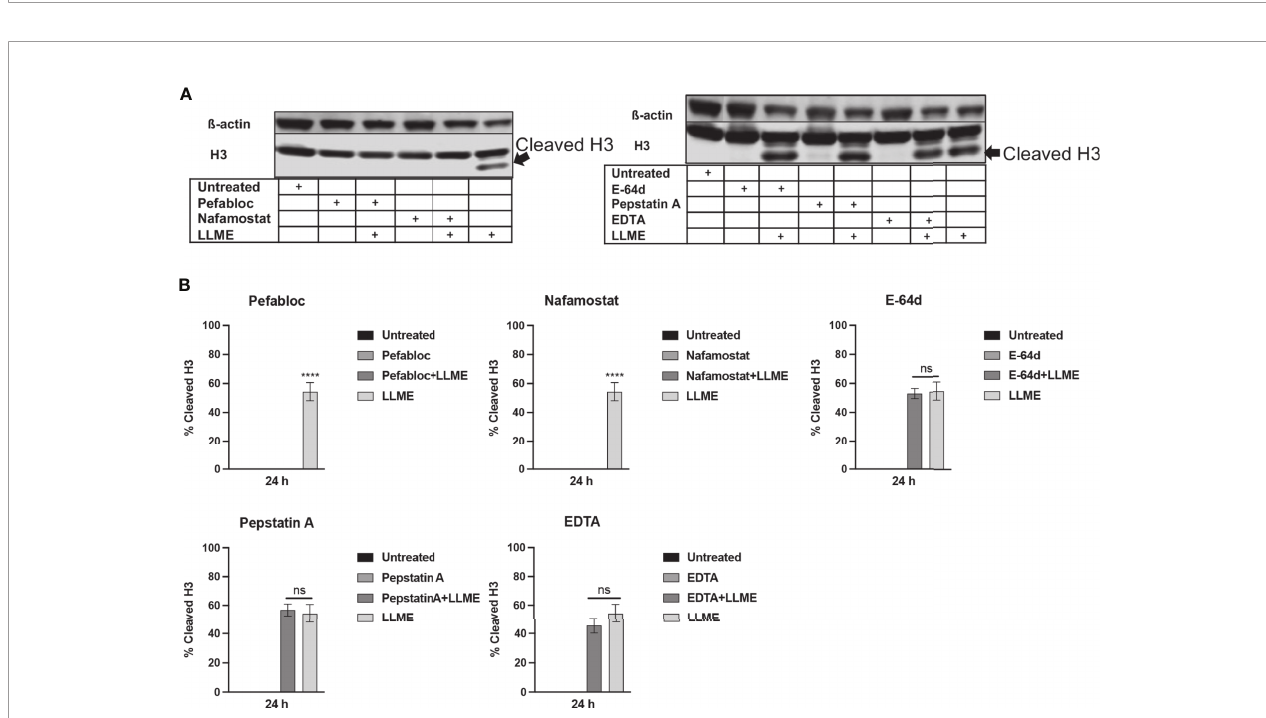
FIGURE 4 | Treatment of mast cell leukemia cells with tryptase inhibitor abrogates H3 cleavage in response to cytotoxic agents. (A) HMC-1 cells (0.5 x 10 6 cells/ml) were incubated with protease inhibitors: Pefabloc SC (Pefa; 0.1 mM), nafamostat (Nafa; 20 m M), E-64d (15 m M), Pepstatin A (Pep A; 50 m M) or EDTA (20 m M) for 30 min prior to treating the cells with LLME (400 m M) for 24 h. Subsequently, samples corresponding to equal numbers of cells were subjected to Western blot analysis for histone 3 (H3), with ß-actin as loading control. (B) Quanti fi cation of the signal intensity for cleaved H3, as % of total H3. The presented data are representative of at least two independent experiments, and are given as mean values ± SEM (n=3). ****p ≤ 0.0001. ns, not signi fi cant.